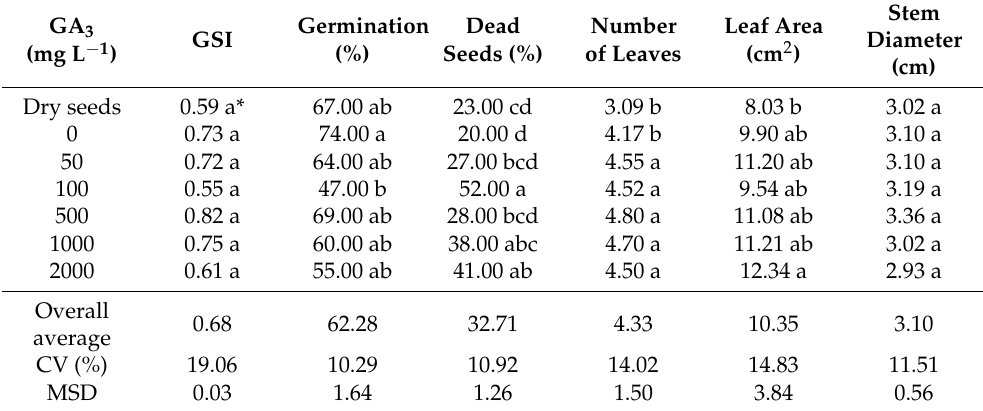
Table 2. Germination speed index (GSI), percentage of germination and dead seeds, number of leaves, leaf area and stem diameter in C. brasiliense seedlings from seeds stored for 40 days, pre-soaked in concentrations of GA 3 and dried, without pre-imbibition, at 60 days after sowing in tubes. Stem Germination Dead Number Leaf Area GA 3 Diameter GSI (%) Seeds (%) of Leaves (cm 2 ) (mg L − 1 )